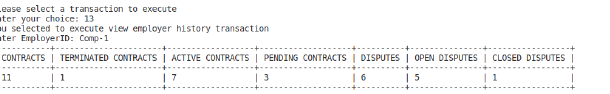
Figure 13. Showing statistics about the employment contracts of a specific